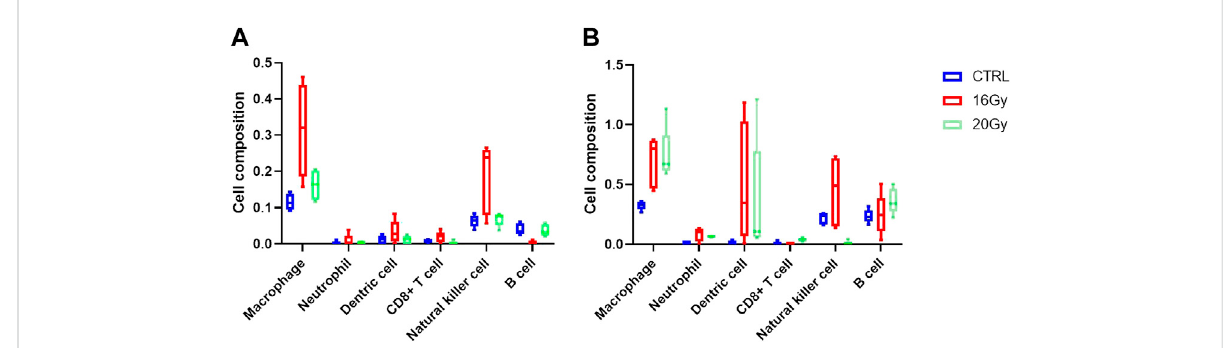
FIGURE 6 Immune cell in fi ltration estimation. Thirty mice were randomized into 3 groups: control group, low-dose irradiation (16 Gy) group and high- dose irradiation (20 Gy) group. Lung tissues were harvested at 3 and 6 months after radiation. (A) Relative proportion of estimated immune cell subsets in each group at 3 months (B) Relative proportion of estimated immune cell subsets in each group at 6 months. CTRL, control